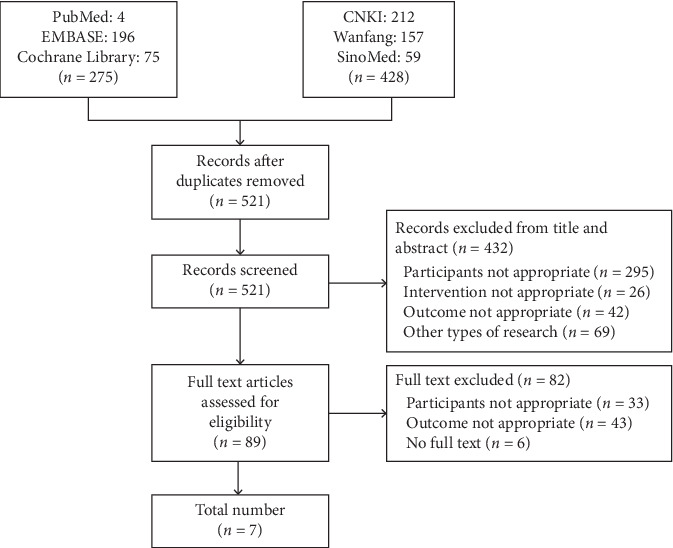
Study flow diagram.